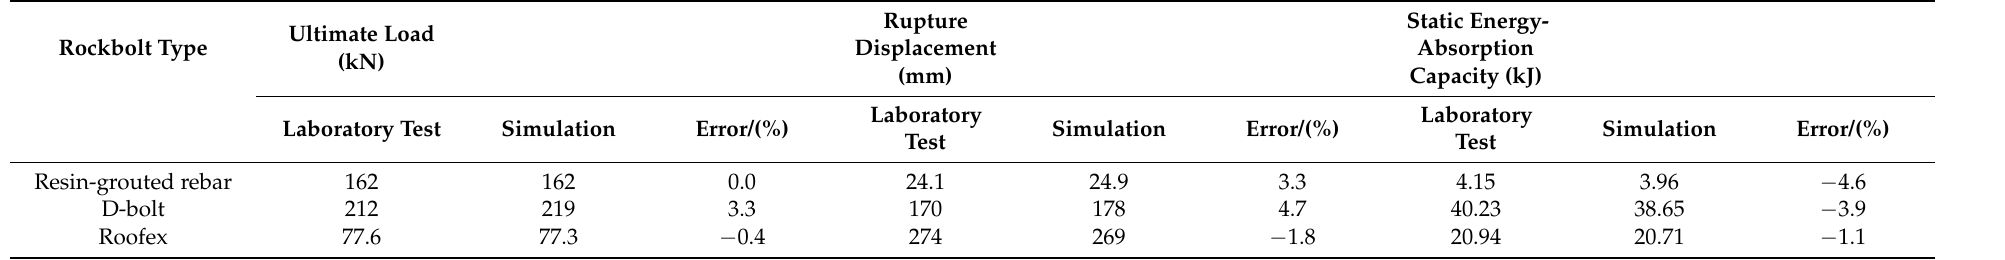
Table 6. Comparison between the targeted and simulated rockbolt